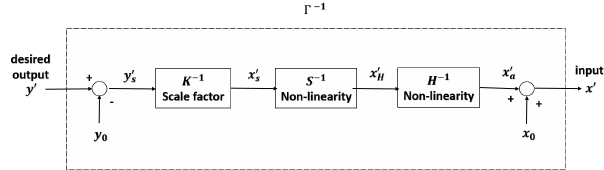
Figure 6. Block diagram of the inverse model as a feedforward